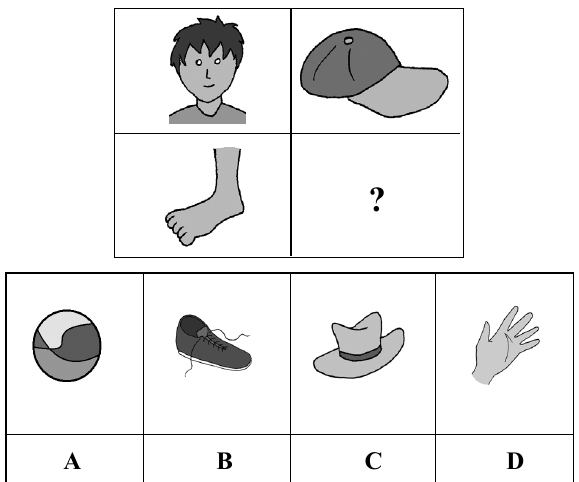
Figure 3 . Item of Recognizing/Differentiating Relationships (RE).